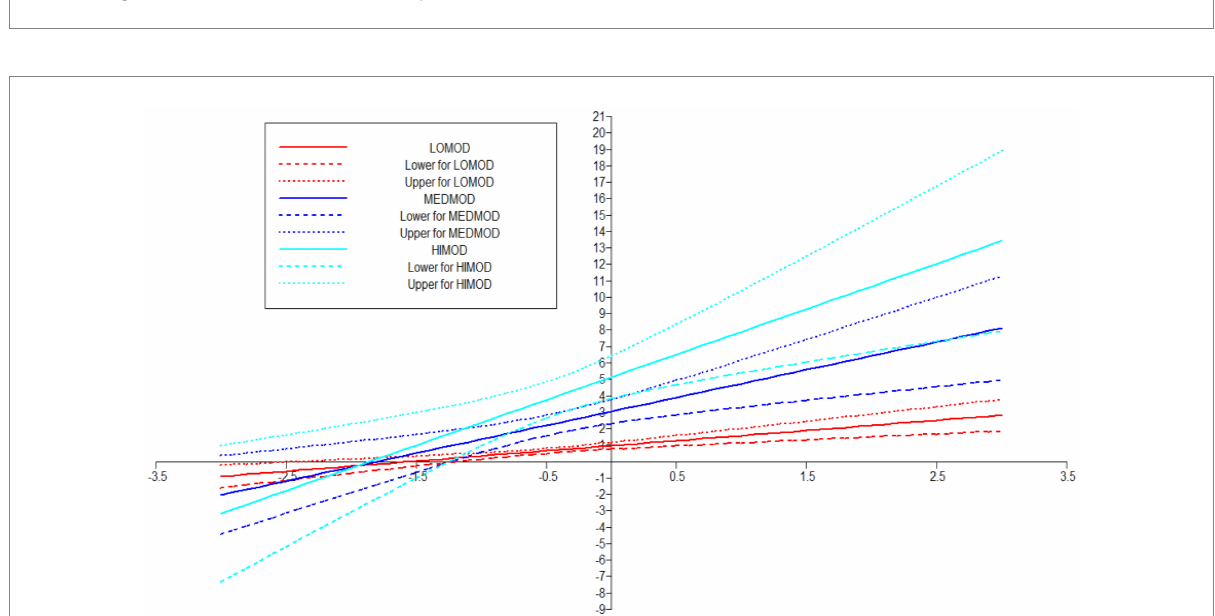
FIGURE 8 Moderating effect of PSS on FS—COP relationship.